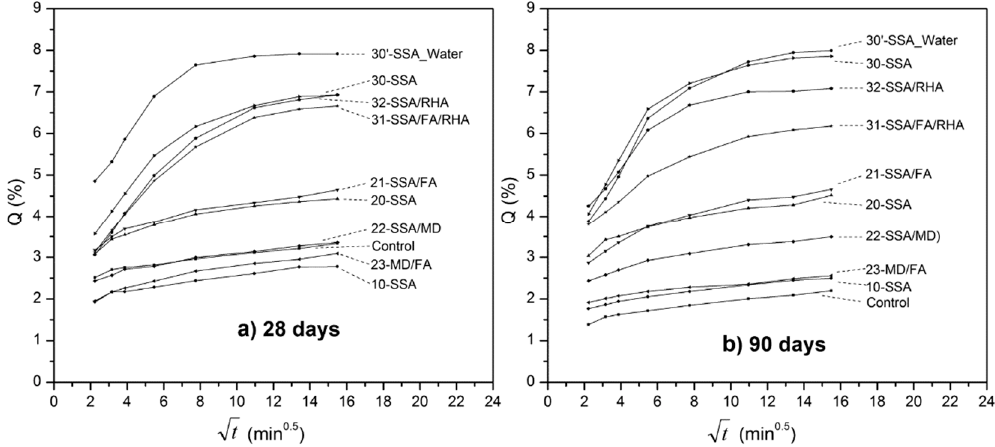
Figure 4. Mass gain (average) by capillary water absorption (Q) against square root of time for specimens cured: ( a ) 28 days; ( b ) 90 days.